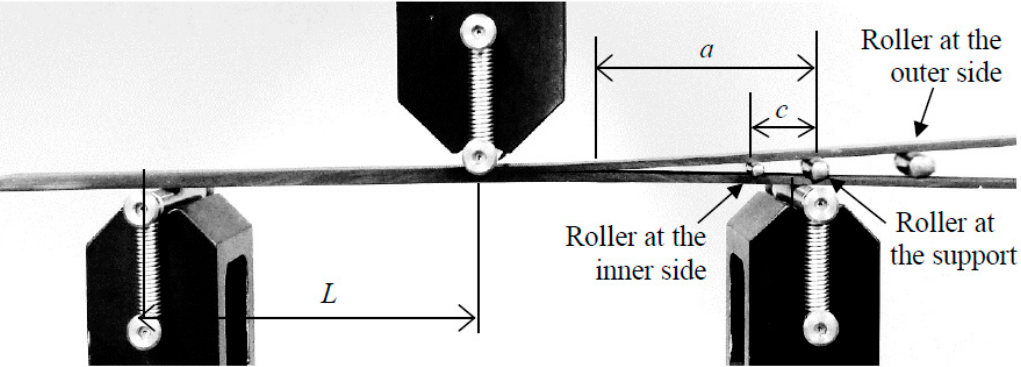
Figure 4. Test configuration showing the three positions of the roller [42].